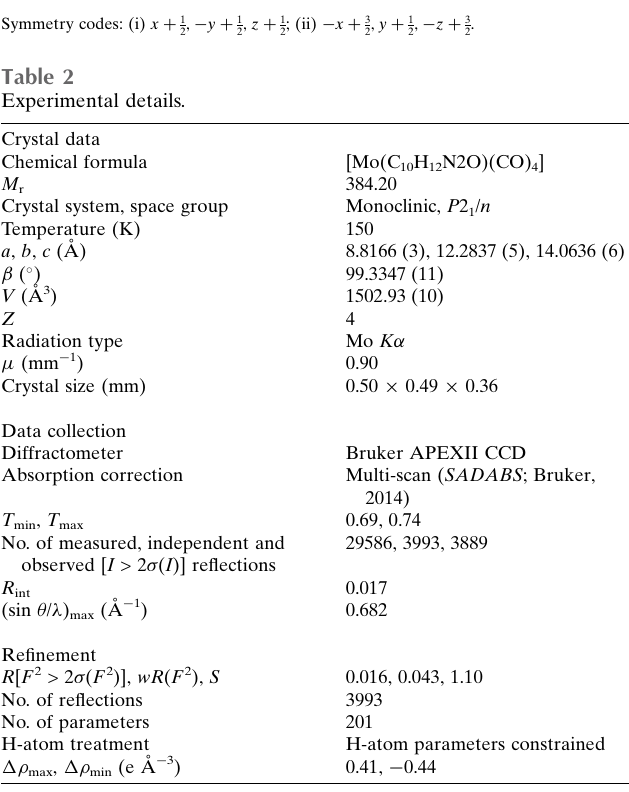
Table 2 Experimental details.